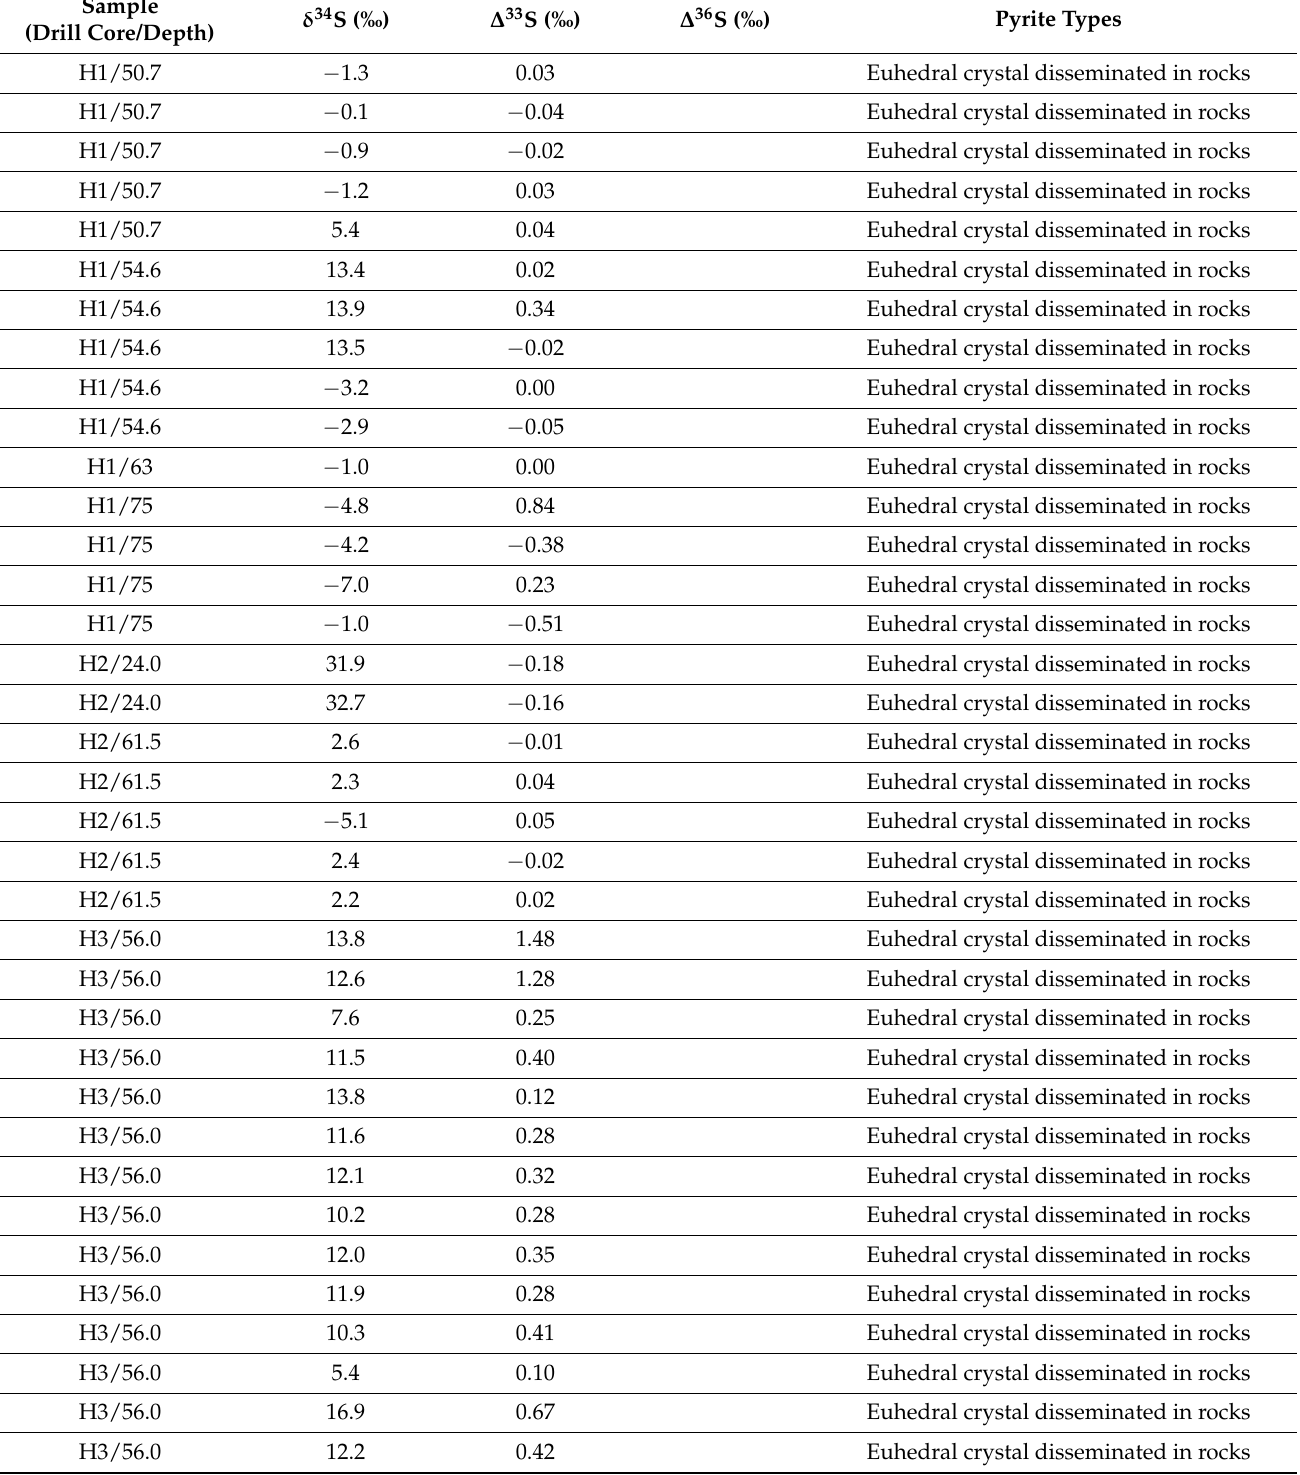
Table A1. Isotopic data for pyrite from sedimentary rocks of the Leksa